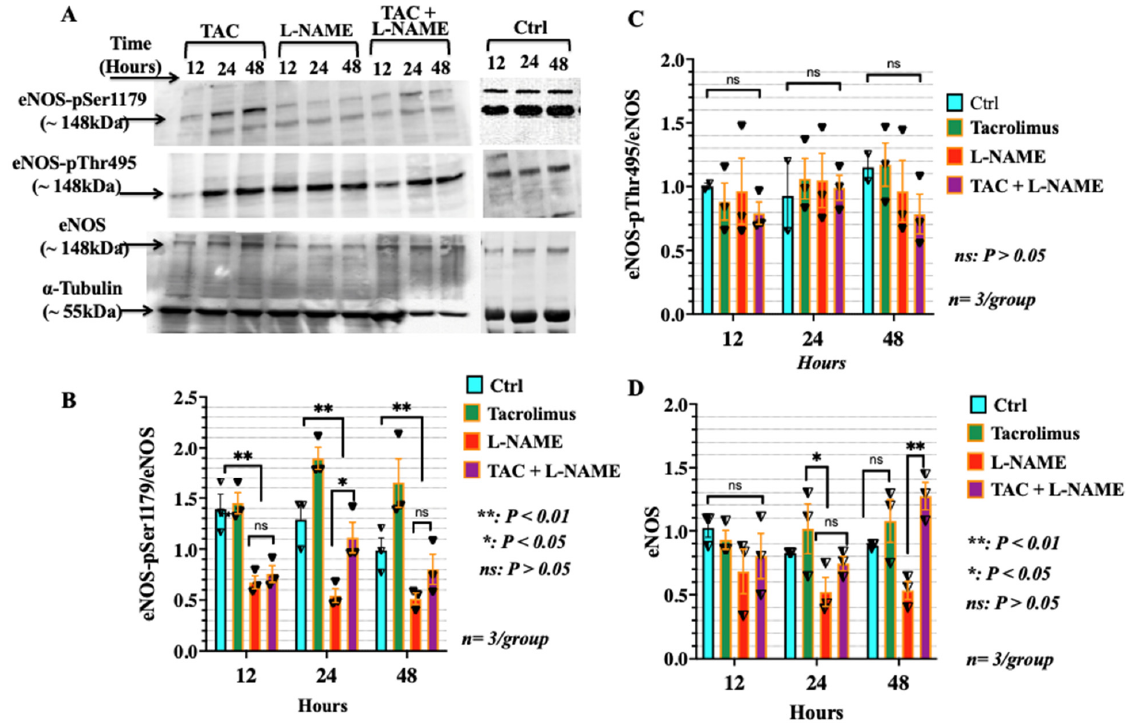
Figure 6. Low-dose tacrolimus stimulates the expression of the eNOS and rescues the phosp- horylation of its active domain eNOS p-Ser 1179 in the L-NAME-challenged HTR-8/SVneo